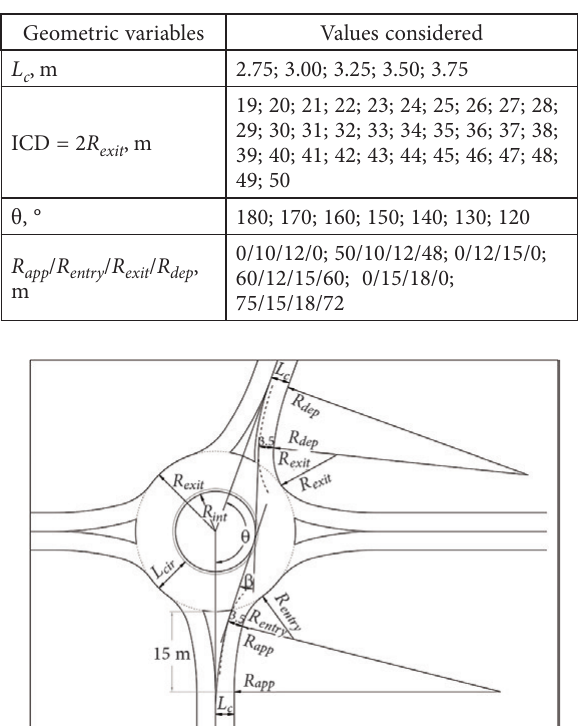
Table 4. Values of the geometric variables considered